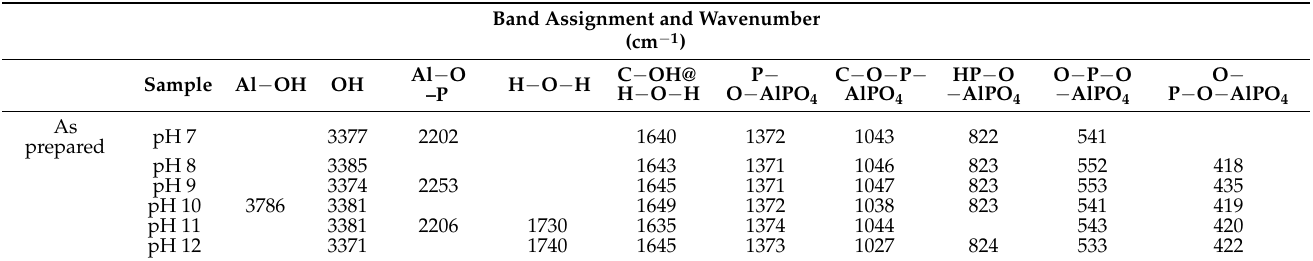
Table 4. Interpretation of PPVA-AlPO 4 nanocomposite FTIR spectra at various pH values (7, 8, 9, 10, 11, and 12). Band Assignment and Wavenumber (cm − 1 )